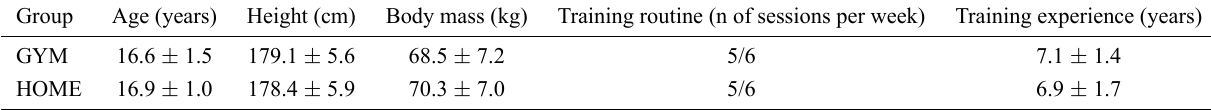
Table 1. Participants and group in close characteristics (mean ± standard